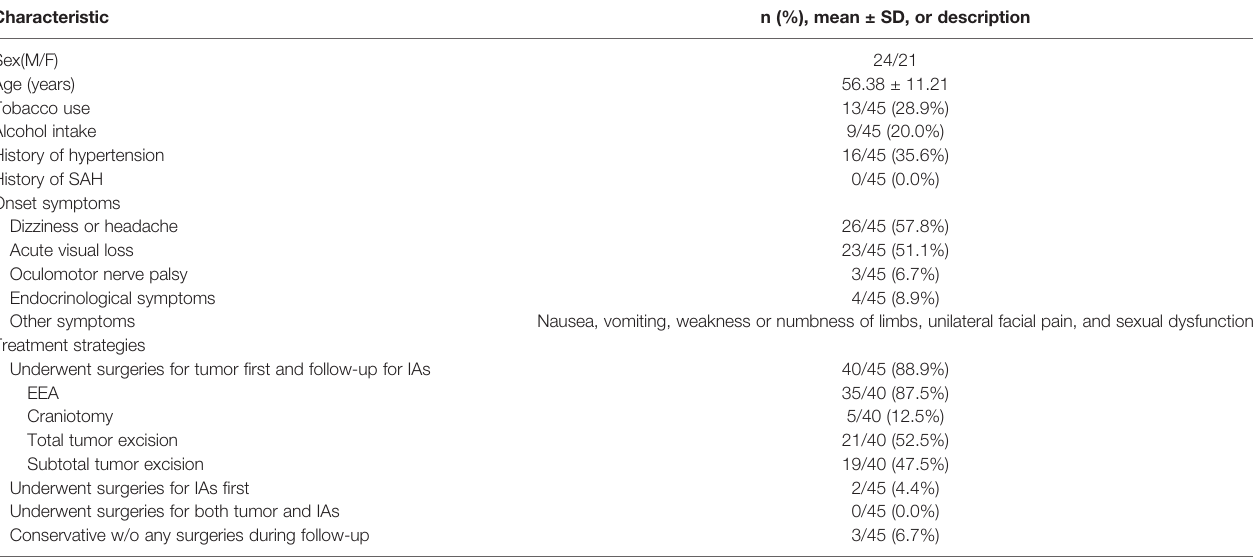
TABLE 1 | Baseline characteristics of included